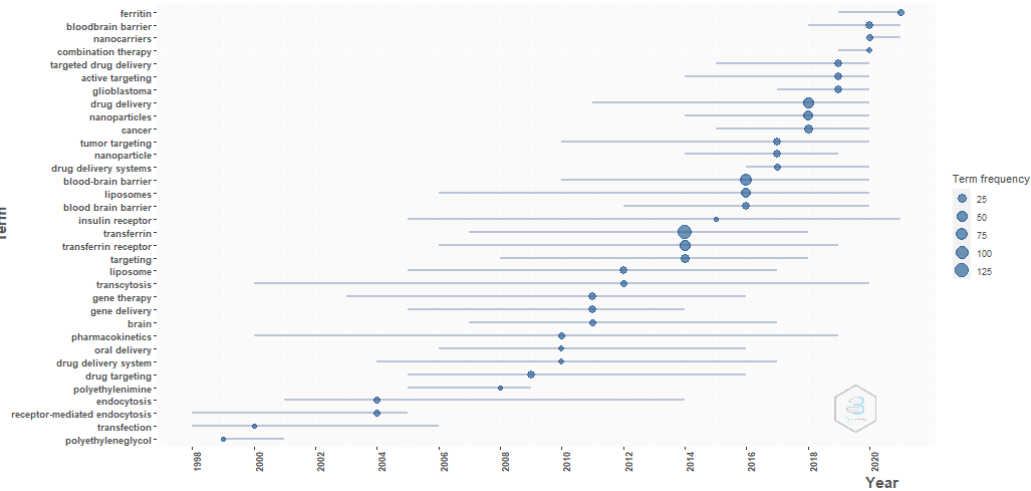
Figure 15. Trending topics. Source: Authors’ elaboration using the Bibliometrix R-package.